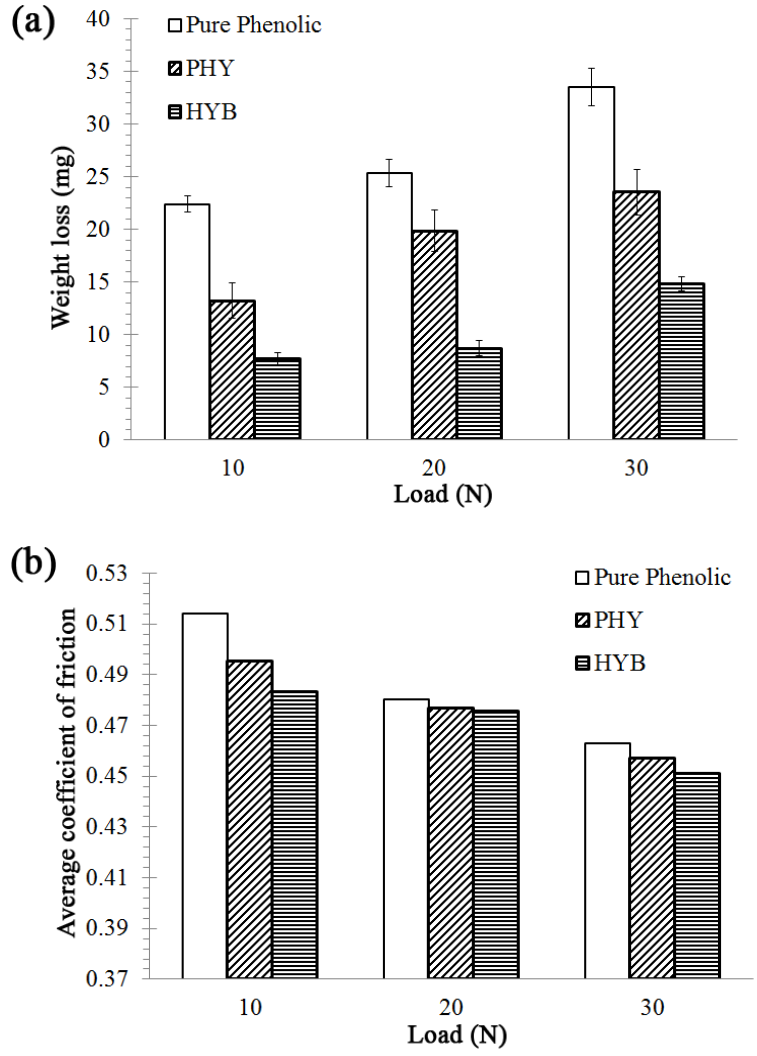
Figure 6. Properties of the HYB composite and PHY composite after wear test for different materials with the variation of applied load (N) (Sliding speed: 1.022 m/s, Filler: 5 wt%): ( a ) weight loss and ( b ) average coefficient of